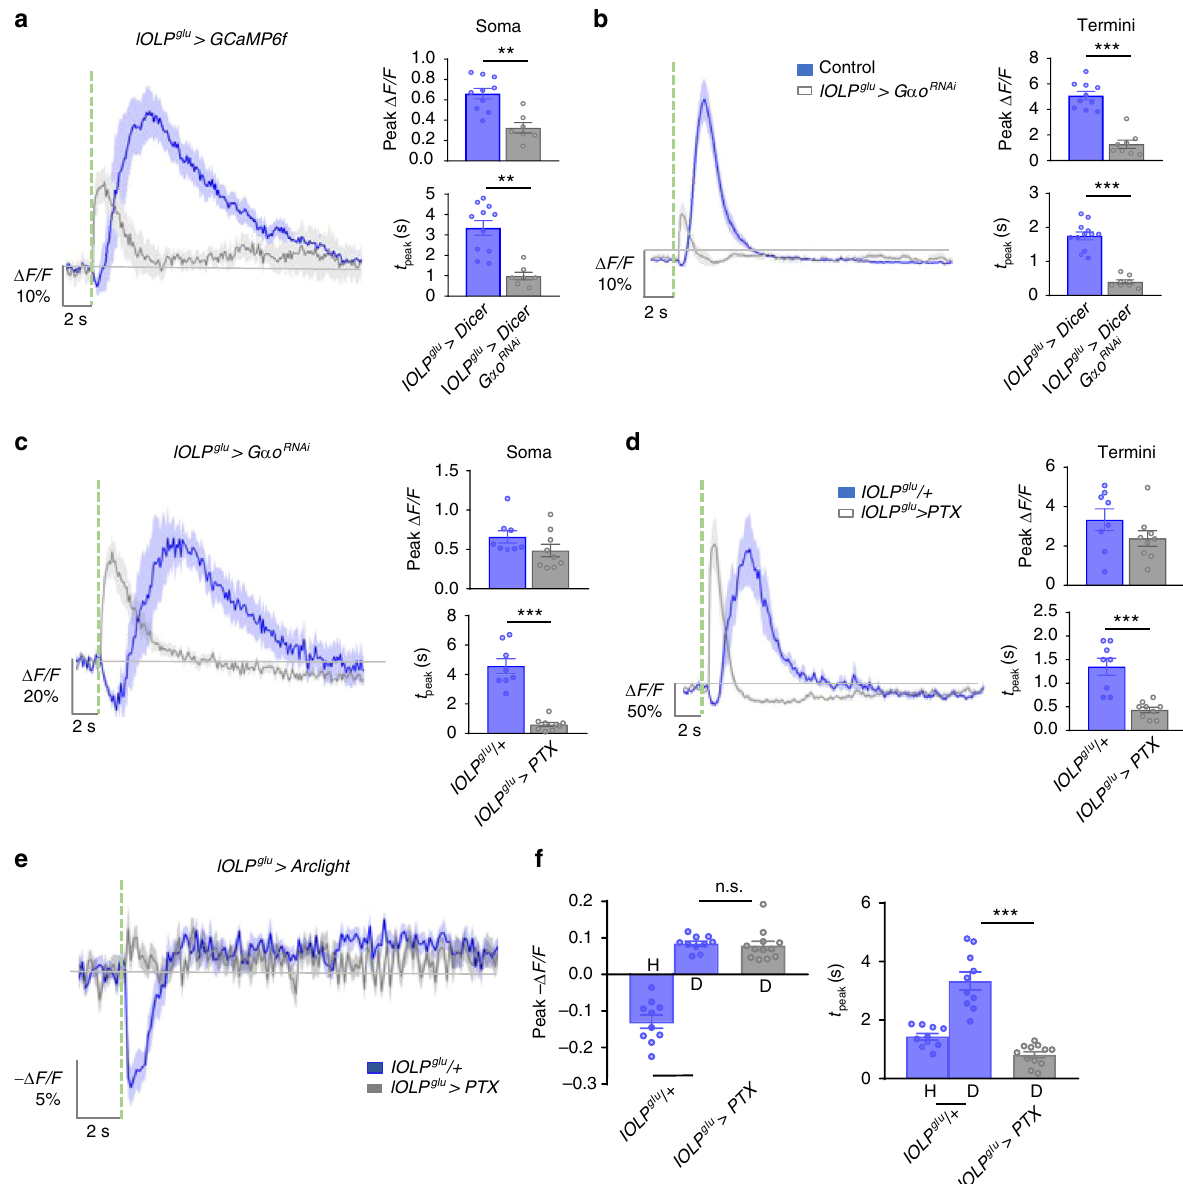
Fig. 5 G α o signaling regulates light-evoked responses in glu-lOLP. a , b RNAi knockdown of G α o reduces the amplitude and latency of the calcium rise in glu-lOLP. Average traces of the changes in GCaMP signals (left) and the quanti fi cations of peak value and peak time (right) of changed intensity ( Δ F / F ) are shown. lOLP glu > Dicer, n = 10; lOLP glu > Dicer, G α o RNAi , soma: n = 7; termini: n = 8. Soma — peak value: p = 0.0005; peak time: p = 0.0002. Termini — peak value: p < 0.0001; peak time: p < 0.0001. Statistical signi fi cance was determined by Student ’ s t test. c , d Expression of the G α o inhibitor PTX accelerates the light-induced calcium rise in glu-lOLP without affecting its amplitude. lOLP glu > GCaMP6f signals were collected at the soma and termini of glu-lOLPs. Average traces of the changes in GCaMP signals (left) and the quanti fi cations of the peak value and peak time (right) of changed intensity ( Δ F / F ) are shown. lOLP glu / + , n = 8; lOLP glu > PTX, n = 9. Soma — peak value: p = 0.145; peak time: p < 0.0001. Termini — peak value: p = 0.1723; peak time: p = 0.0001. Statistical signi fi cance was determined by Student ’ s t test. e , f PTX expression transforms light-induced hyperpolarization into depolarization in glu-lOLP. Light-evoked voltage changes in glu-lOLP measured by Arclight expression driven by lOLP glu -Gal4 exhibits a biphasic response, a large hyperpolarization (H) followed by a small depolarization (D), in the control group. PTX expression eliminates the hyperpolarization and reveals a depolarization. Average traces of changes in Arclight signals (left) and the quanti fi cations of the peak value and peak time (right) of changed intensity ( − Δ F / F ) are shown. lOLP glu / + , n = 10, lOLP glu > PTX, n = 12. Peak value: ANOVA: p < 0.0001, F = 66.92, df = 35; lOLP glu / + -lOLP glu > PTX: p = 0.9883. Peak time: ANOVA: p < 0.001, F = 42.32, df = 35; lOLP glu / + -lOLP glu > PTX: p < 0.0001. Shaded areas on traces and error bars on quanti fi cations represent SEM. The dashed green line represents a 100 ms light pulse at 561 nm. Statistical signi fi cance was determined by one-way ANOVA with post hoc Tukey ’ s multiple comparison ’ s test. n.s.: p ≥ 0.05 was considered not signi fi cant, ** p < 0.01, *** p <